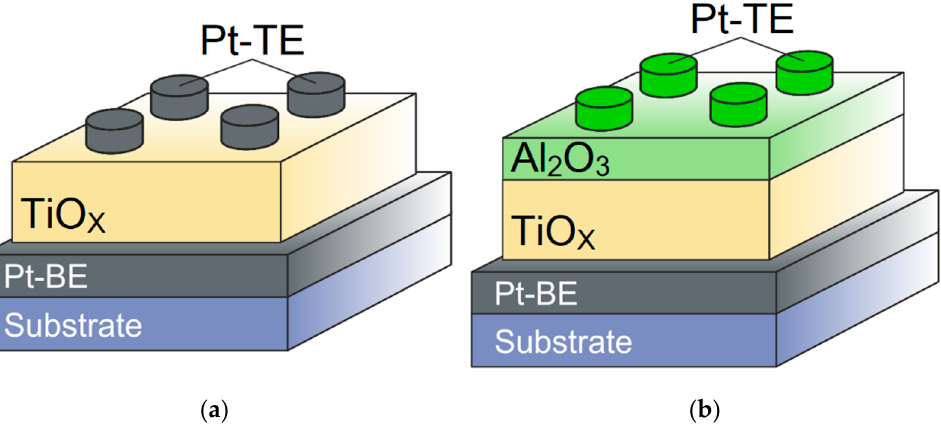
Figure 2. Structures of the memristors based on TiO x ( a ) and TiO 2 /Al 2 O 3 ( b ) films.